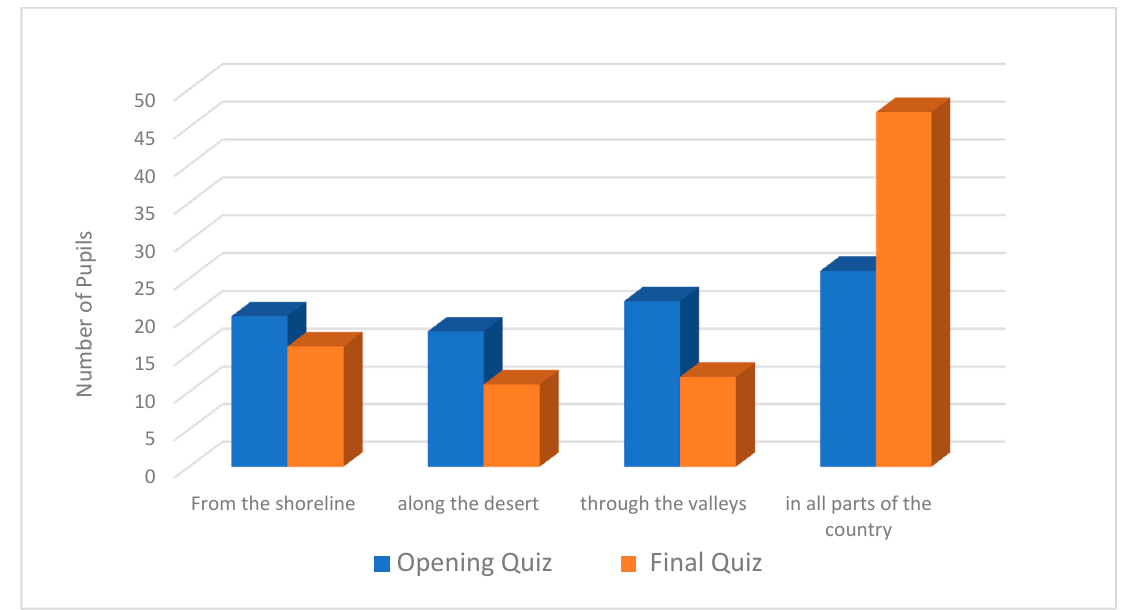
Figure 6. Results for the question “Where does electricity come from?”.